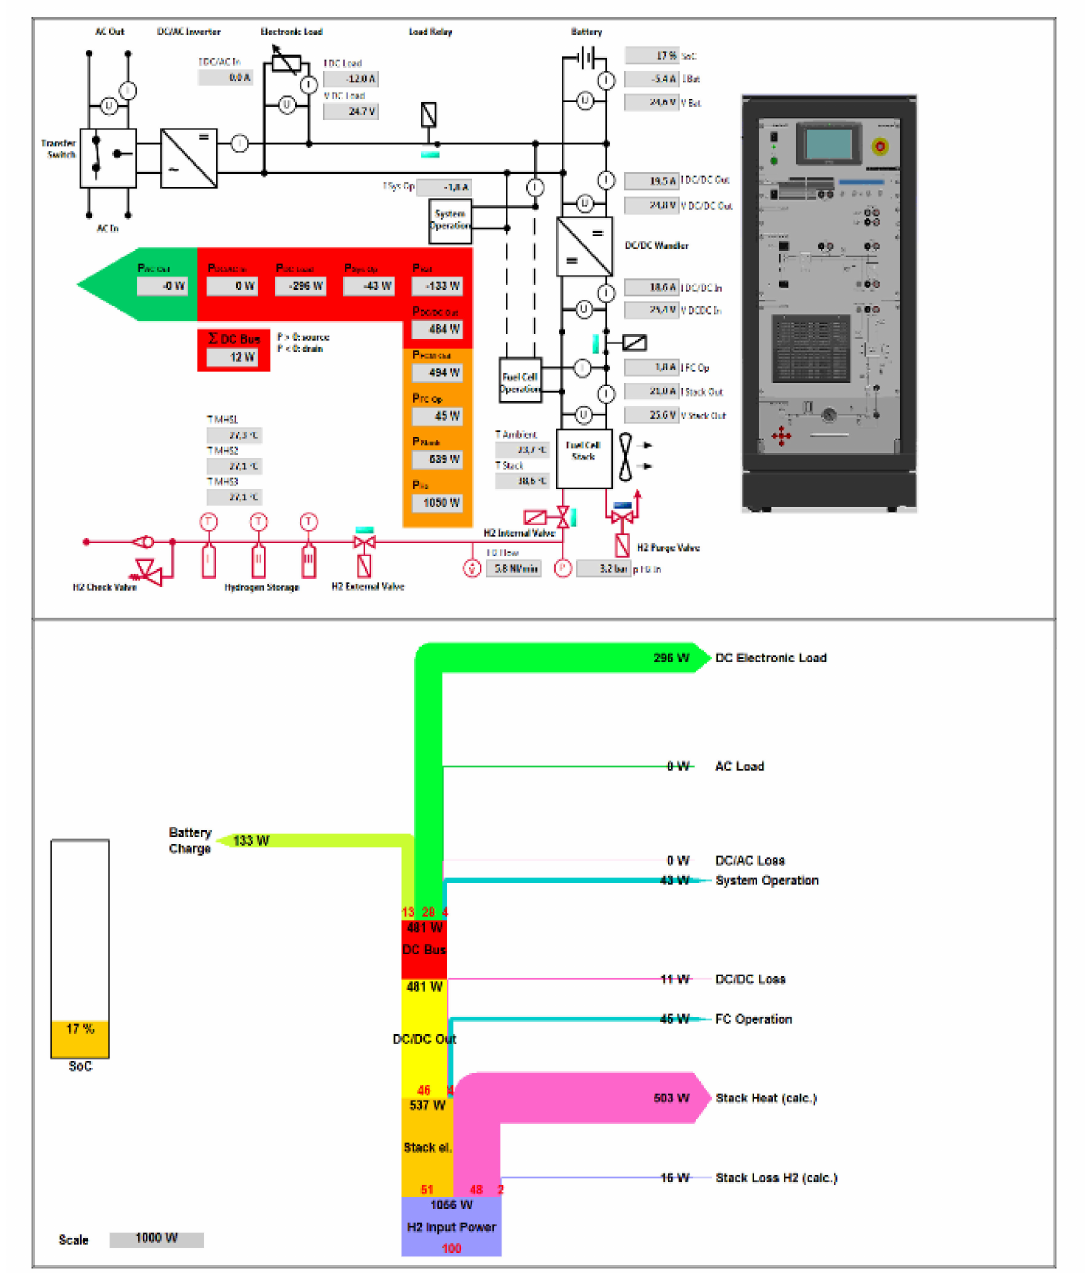
Figure 10. GUI of PEMFC Stack, Components, and Sankey